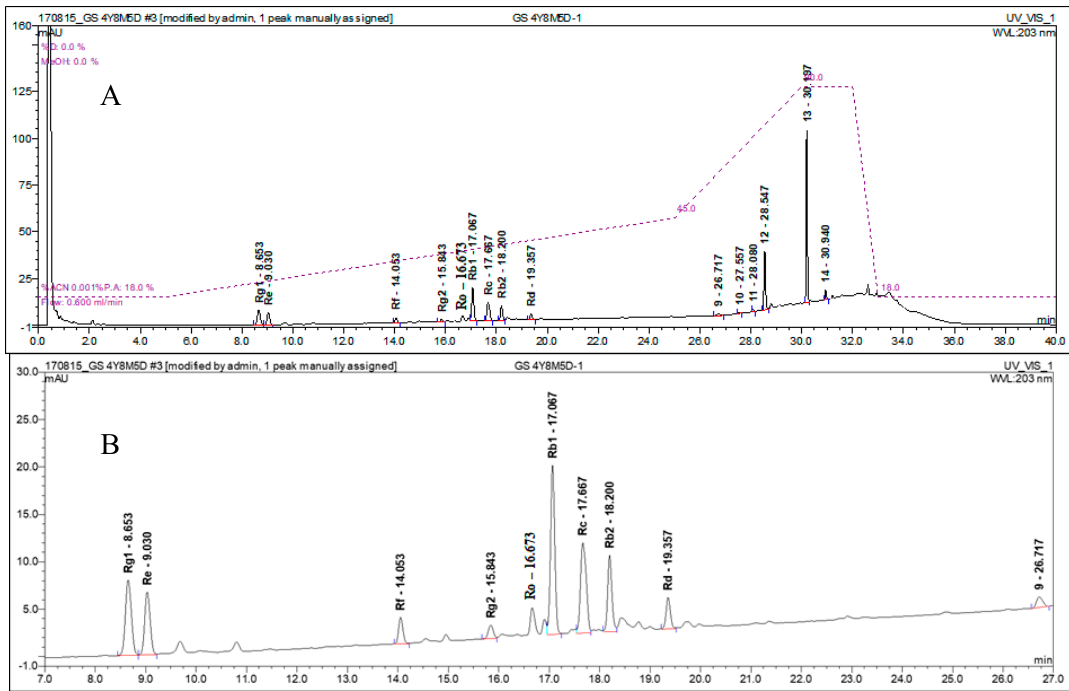
Figure 1. UHPLC chromatogram (203 nm) of the ginseng analytes ( A ) and the expansion ( B ) showing nine ginsenosides.